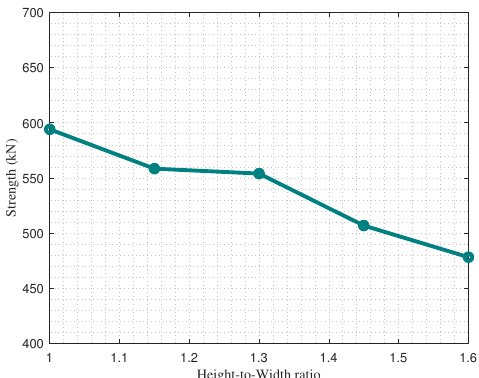
Figure 12. Shear wall strength S for different H / W